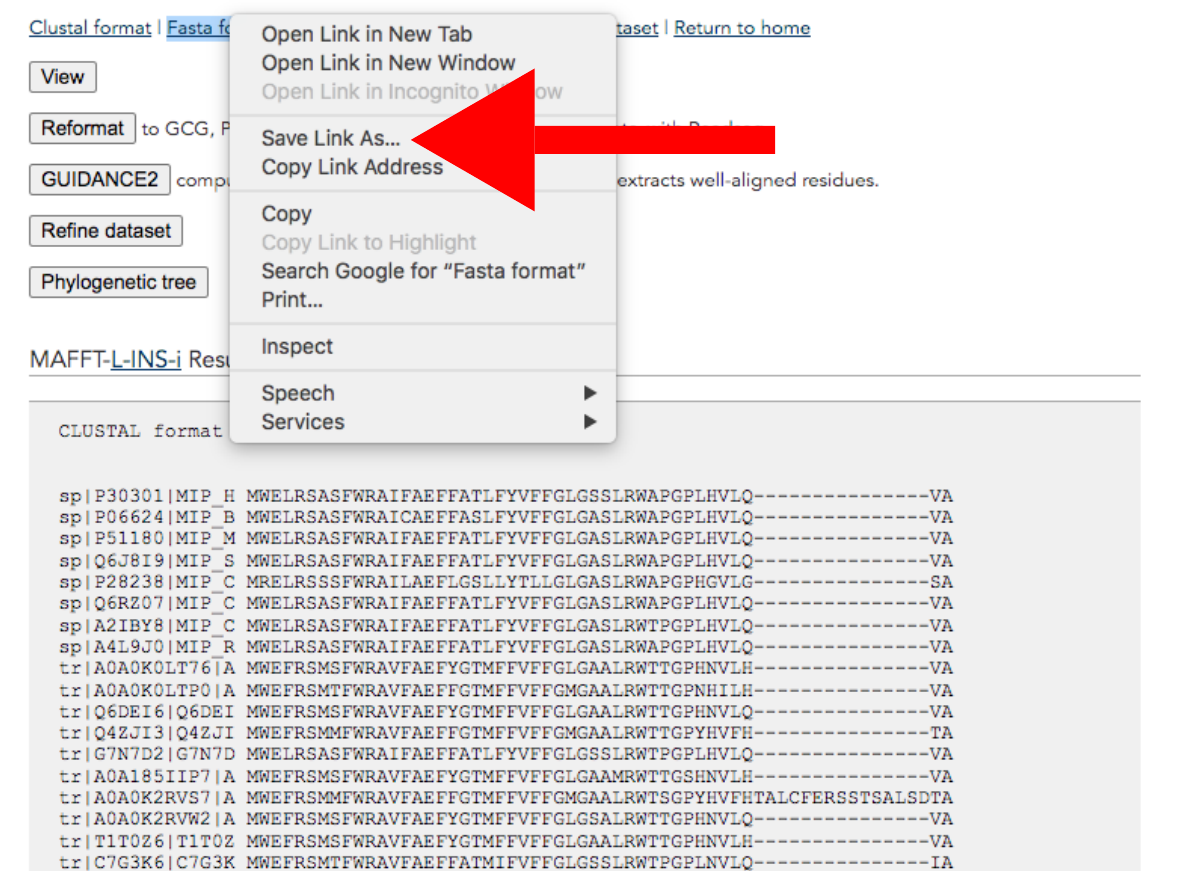
Figure 9. MAFFT result web page. The red arrow indicates Save link As… button for downloading. Accessed on 27 January 2022.